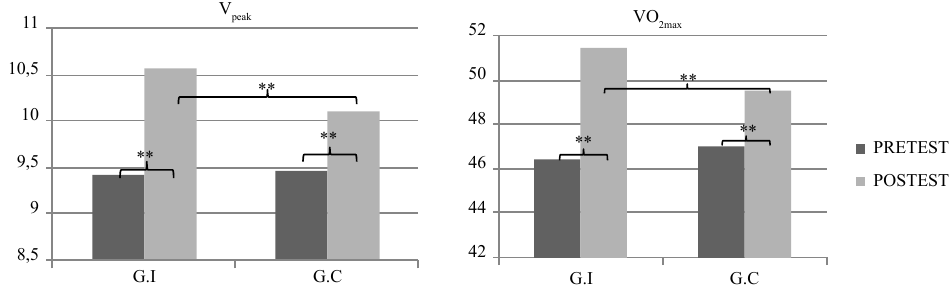
Figure 1. Vpeak and VO ax values recorded in the 20 m shuttle sprint test before and after the control and high-intensity interval training pro- 2 m grams (** p<.01;